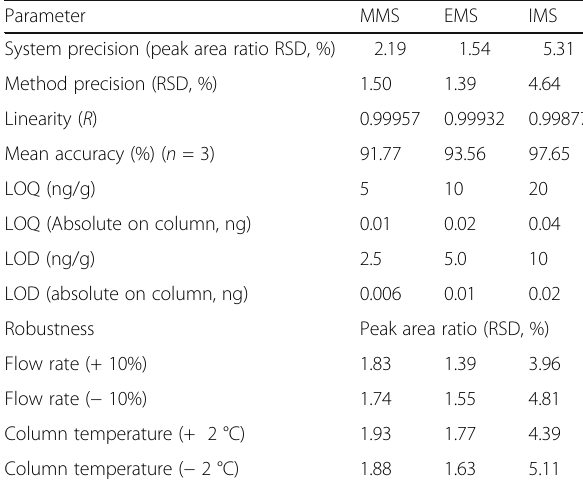
Table 4 Method validation summary Parameter